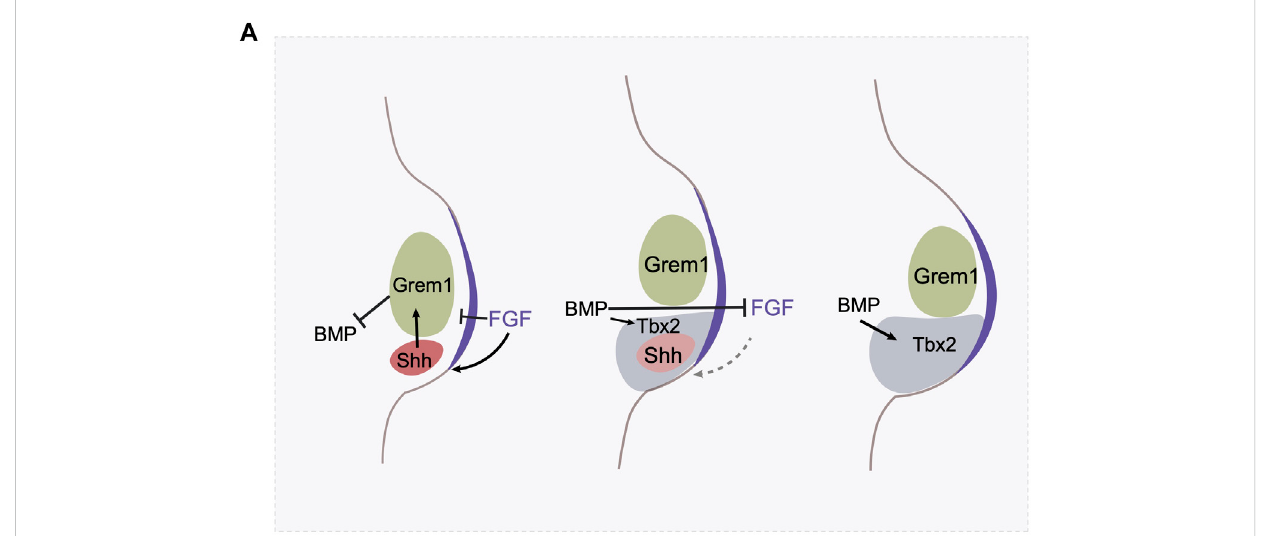
FIGURE 3 The termination of Shh expression involves multiple mechanisms. (A) The AER derived FGF signaling maintains Shh expression, and BMP signaling antagonizesFGFsignalingintheAER.ShhactivatesGremlininthemesenchyme,whichpreventBMP ’ santagonisticeffectonAER.Inthemeantime,FGFat AER prevents Gremlin expression. In the initial stage, the FGF-Shh-Gremlin loop is strong enough to maintain the FGF-Shh loop. Shh expression triggers cellproliferationandthedigitidentityspeci fi cation.However,asthelimbbudexpands,BMPactivatestheexpressionofatranscriptionfactorTbx2in theposteriorregion whichantagonizesGremlin ’ sexpression.Gremlinatthisregionisfurtherhamperedbythehighlevel ofFGFactivity.Asaresult,these negativefeedbackloopsallowthecreationofaspatialgapbetweenZPAandGremlinexpressingdomainandrepressestheFGF-Shhloopandtriggersthe termination of Shh